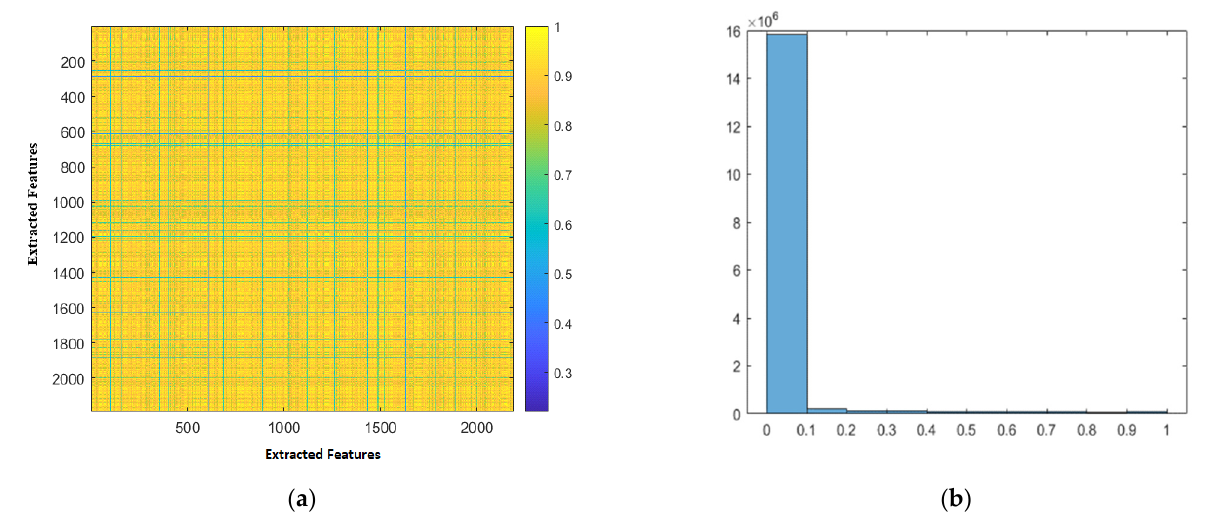
Figure 5. A heatmap for the correlation coefficient between the extracted features and a histogram of the corresponding p -value. ( a ) The heatmap of correlation coefficient; ( b ) Histogram of the p -value.